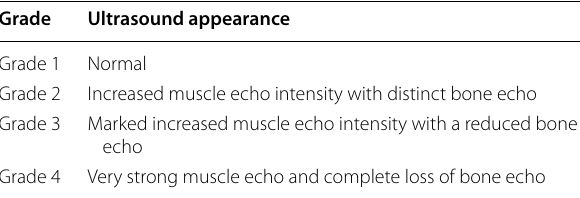
Table 5 Heckmatt Scale: visual grading scale to classify muscle echo intensity (Ref